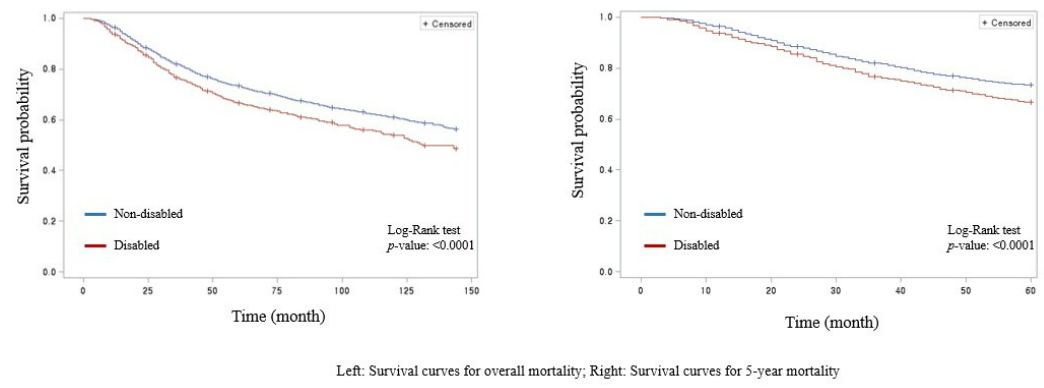
Figure 1. Kaplan–Meier survival curves according to disability status. Table 3. Results of the subgroup analysis.